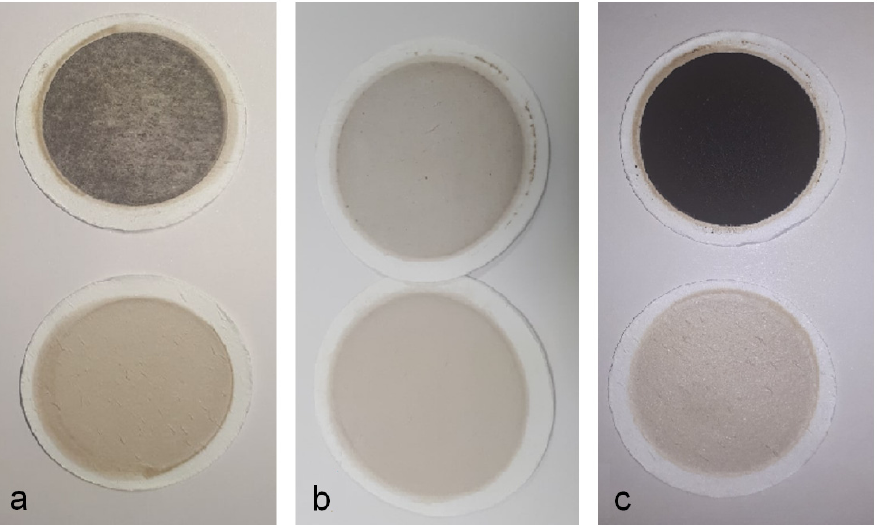
Figure 4. Filters after filtration and determination of total sediment content: ( a )—sample No.1; ( b )—sample No.2; ( c )—mixture of samples No.1 and No.2.